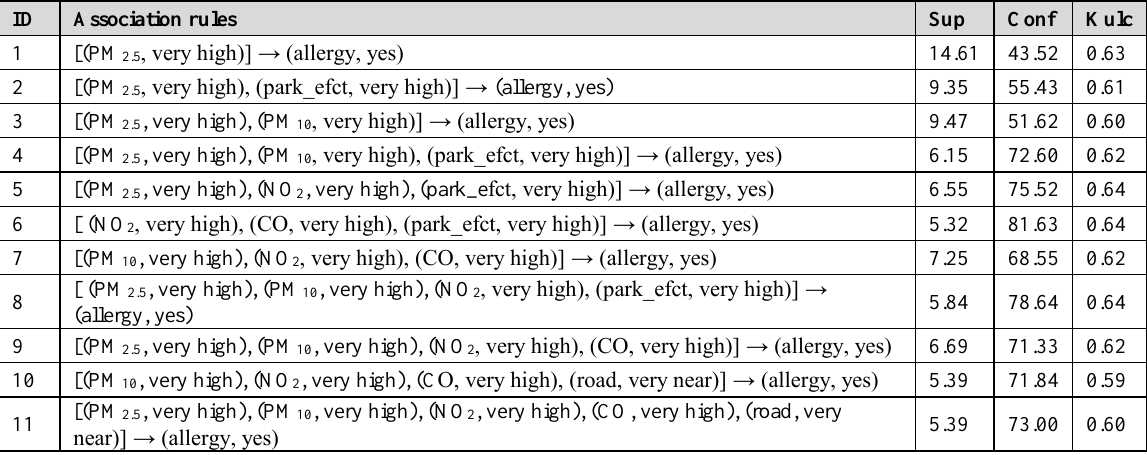
Table 3. Some of the rules extracted for December through association rule